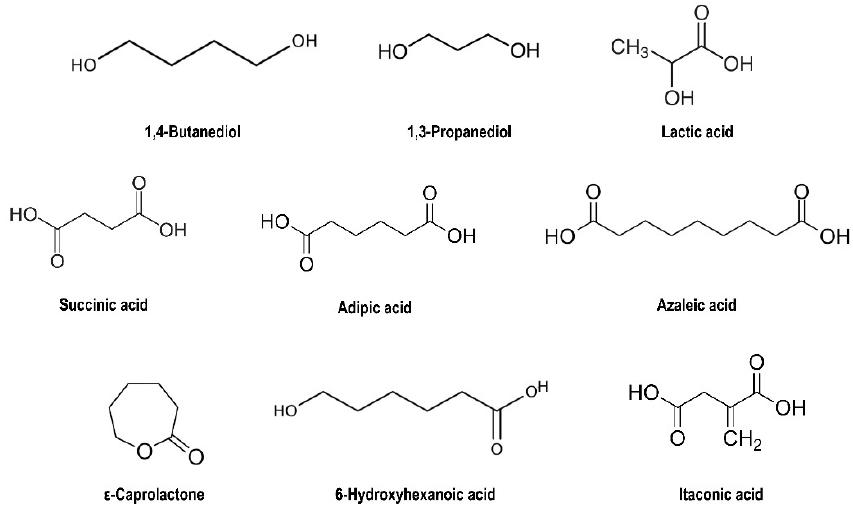
Figure 4. Chemical structure of plastic building